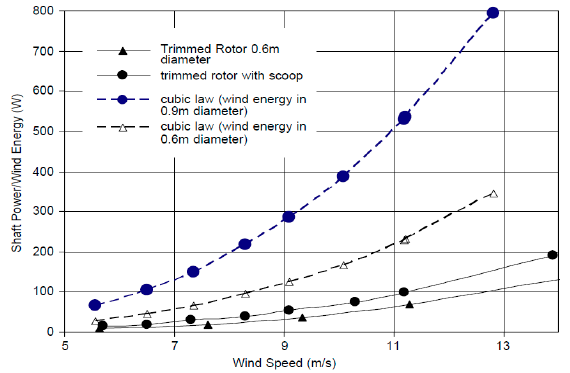
Figure 13. Comparison of Power Output of a scooped blade with a non ‐ scooped blade [120].